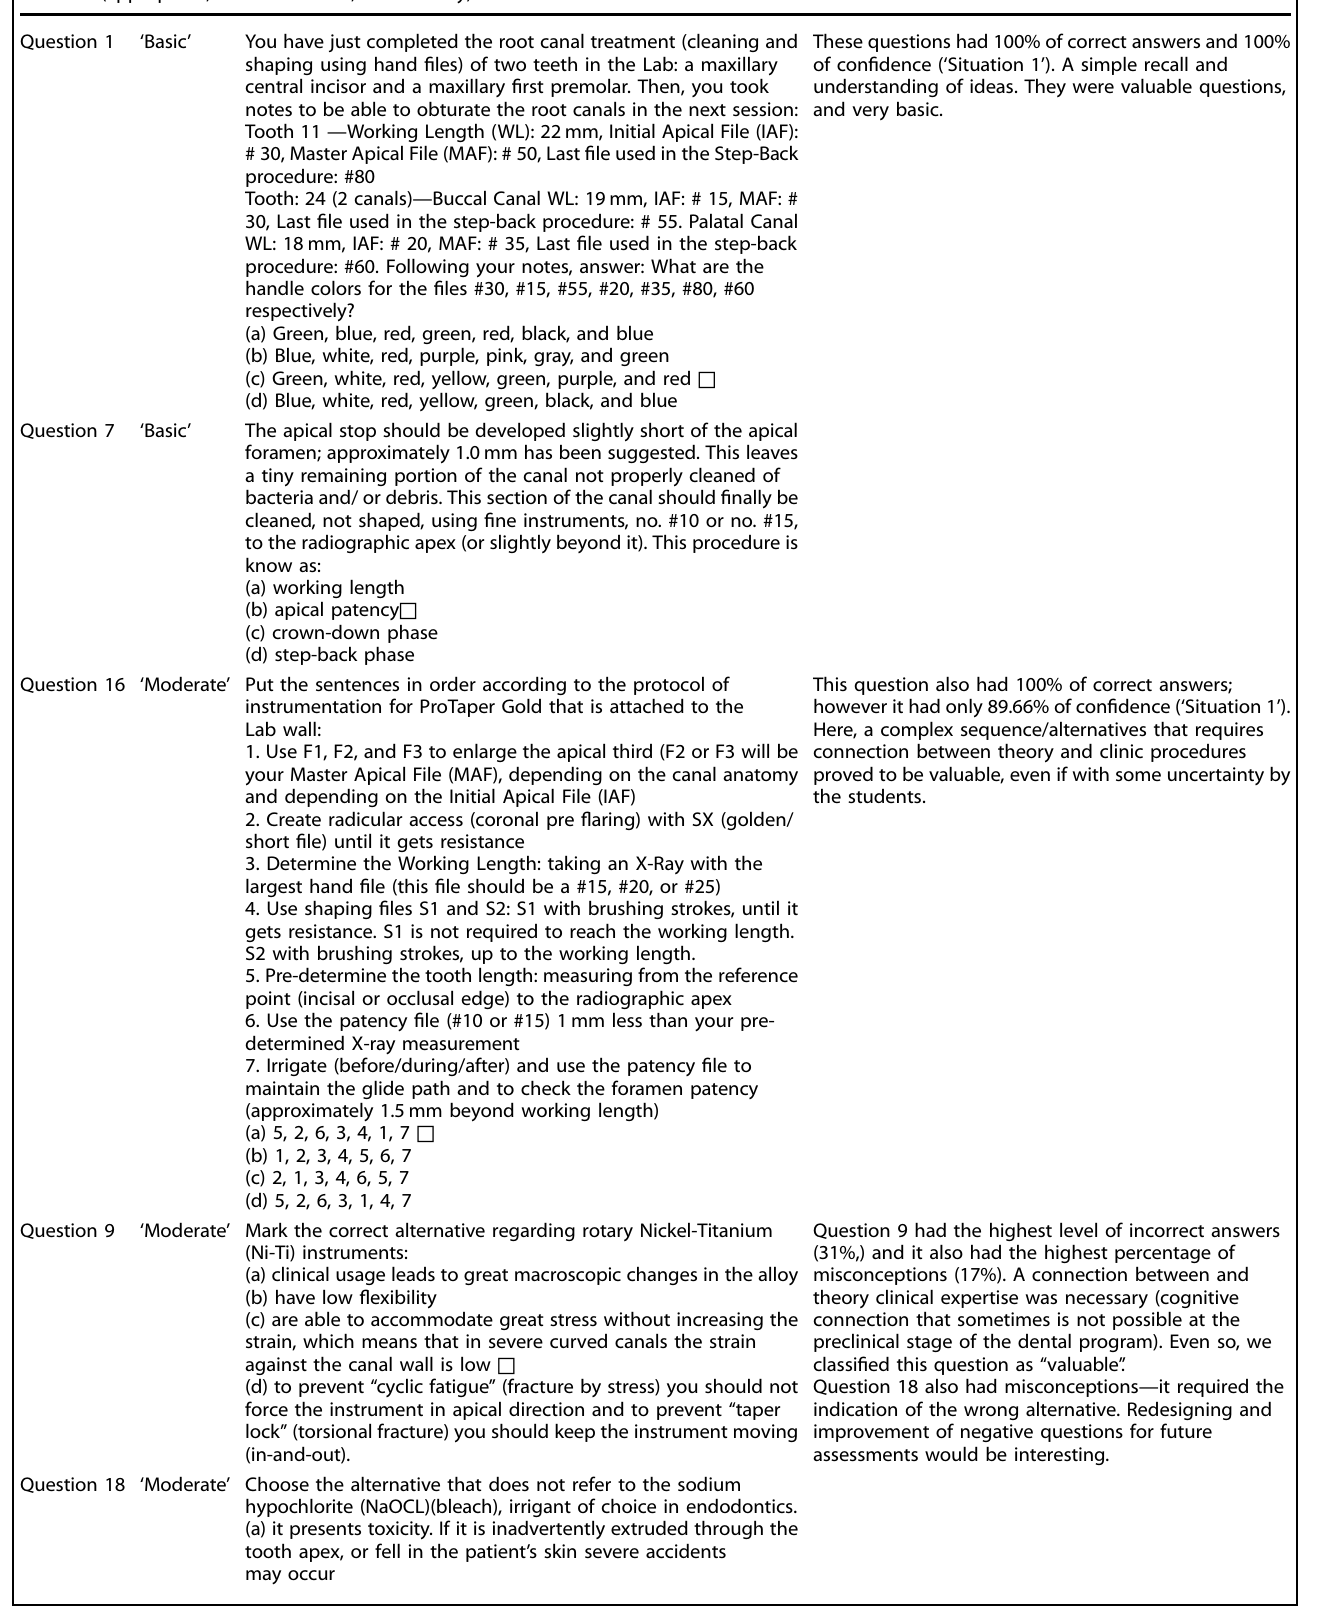
Table 4. Examples of multiple-choice questions, which were part of the endodontic assessment and important fi ndings indicating if the question is valuable (appropriate, understandable, and